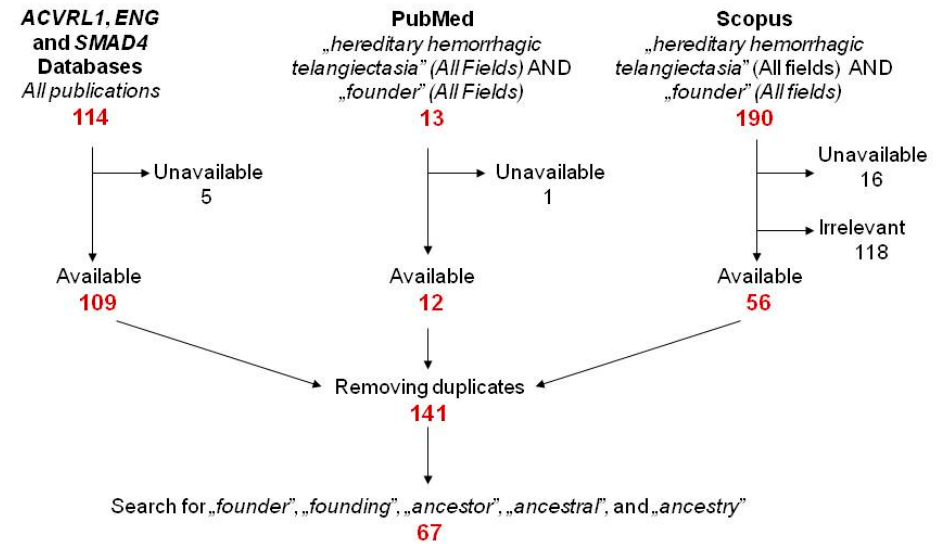
Figure 1. The algorithm of the literature search for hereditary hemorrhagic telangiectasia (HHT) founder effects.